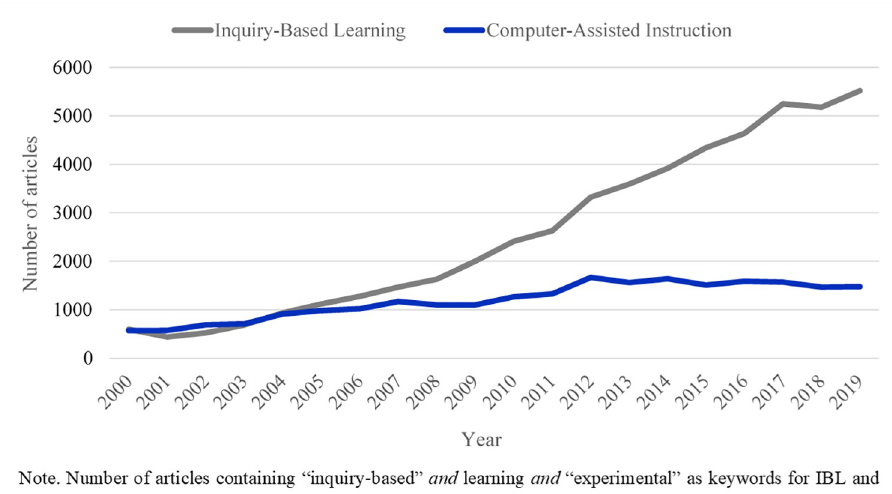
Fig 1. The popularity of IBL and CAI over the past twenty